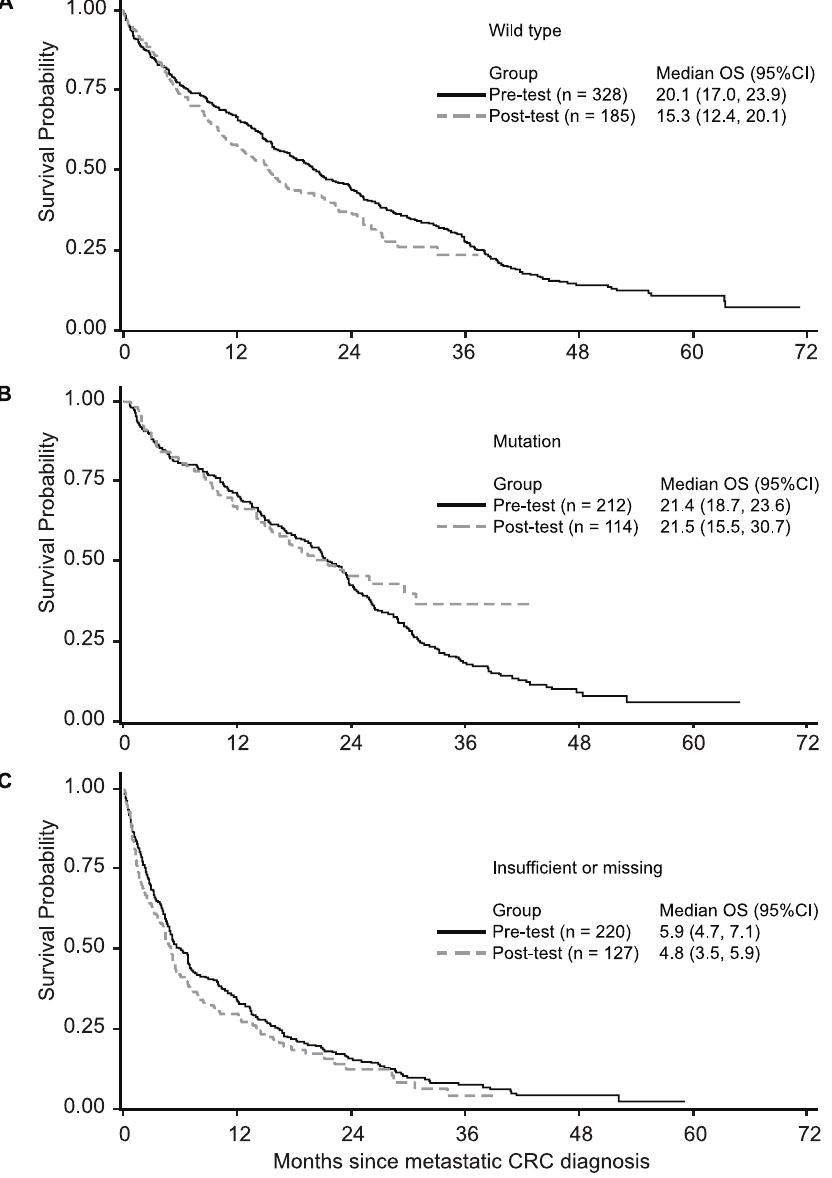
Figure 2. Overall survival in the pre-testing and post-testing groups by KRAS test result. A. Overall survival in the pre-testing and post- testing groups among those with KRAS wild-type tumors. B. Overall survival in the pre-testing and post-testing groups among those with KRAS mutations. C. Overall survival in the pre-testing and post-testing groups among those with no KRAS test results (as a result of insufficient or no tissue available for testing).